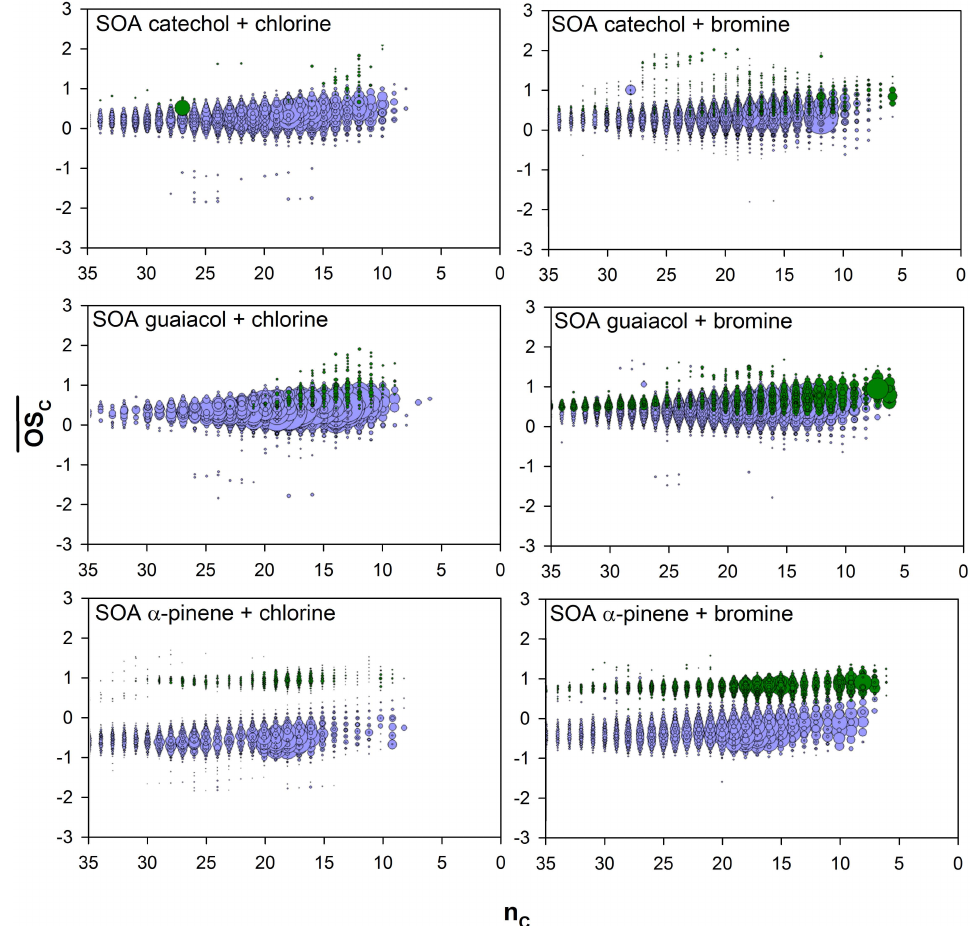
Fig. 8. Averaged carbon oxidation state (OS C ) as a function of the number of carbon atoms n c : unprocessed SOA (blue), halogenated species in the particle phase (green). The SOA was formed and processed in the presence of simulated sunlight at 0% relative humidity. The bubble size expresses the signal intensity from the experimental